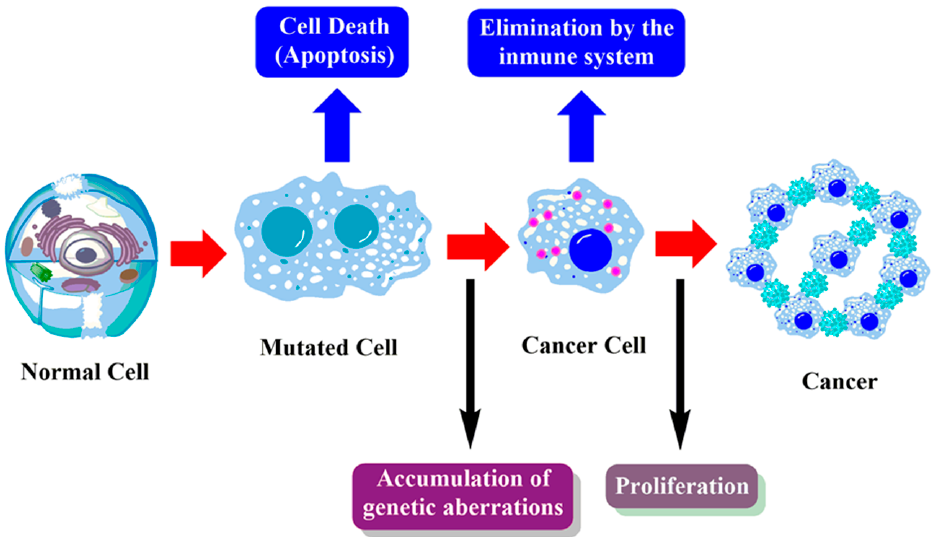
Figure 6. Basic mechanism of carcinogenesis.